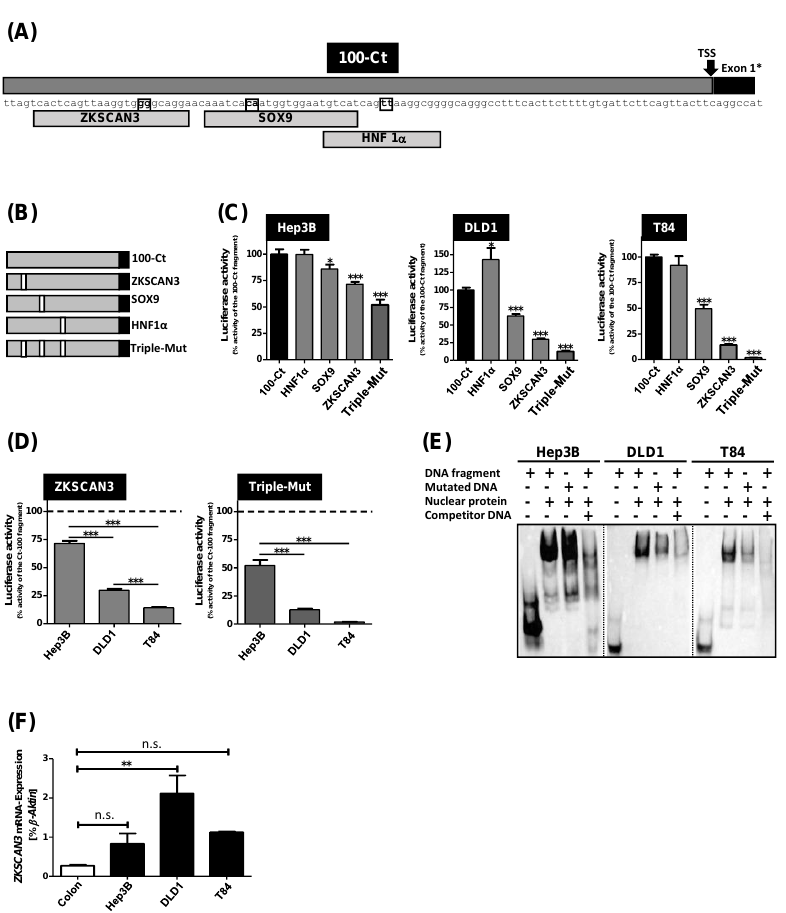
Figure 4. ( A ) Localization of potential transcription factor binding sites of the transcription factors ZKSCAN3, SOX9 and HNF1 α within the 100-Ct fragment. The base pairs marked in the black boxes were mutated in the different constructs shown in ( B ). ( C ) Comparison of the luciferase activity of the mutated 100-Ct constructs in Hep3B, DLD1 and T84 cells with the activity of the non-mutated 100-Ct reporter gene fragment set to 100% (n = 8; Triple-Mut n = 4). ( D ) Influence of the ZKSCAN3 (n = 8) and Triple-Mut (n = 4) mutation on the luciferase activity of the three cell lines. ( E ) EMSA comparing the binding affinity of the nuclear protein fractions of Hep3B, DLD1 and T84 cells with the non-mutated biotinylated DNA fragment (second lane of each cell line) and the triple-mutated biotinylated DNA-fragment (third lane). The unbiotinylated DNA fragment served as competitor DNA (fourth lane). ( F ) Analysis of the ZKSCAN3 mRNA expression in Hep3B, DLD1 and T84 cells and in normal colon total RNA (n = 3). * p < 0.05; ** p < 0.01; *** p < 0.001; n.s. = not significant. TSS = transcriptional start site; Exon 1* = the alternatively spliced first exon of Ct-SLCO1B3